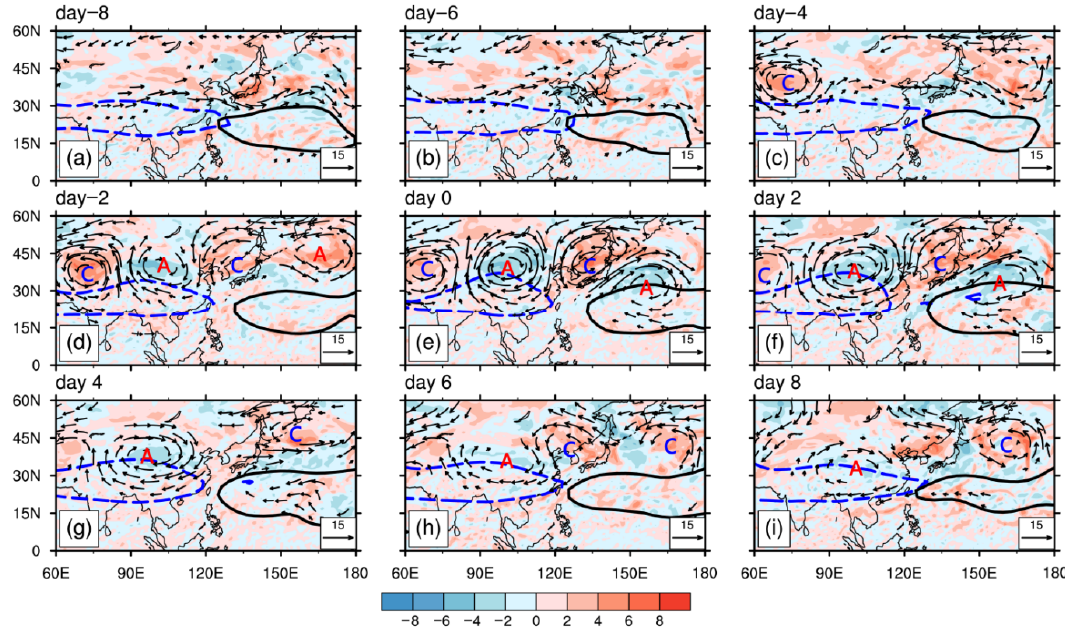
Figure 13. The same as in Figure 10, but for the SRP− events.